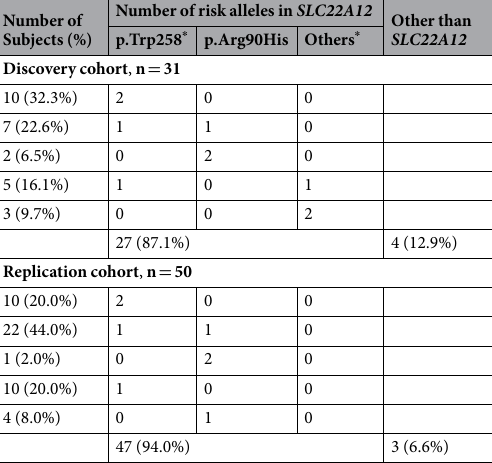
Other than SLC22A12 p.Trp258 * p.Arg90His Others *